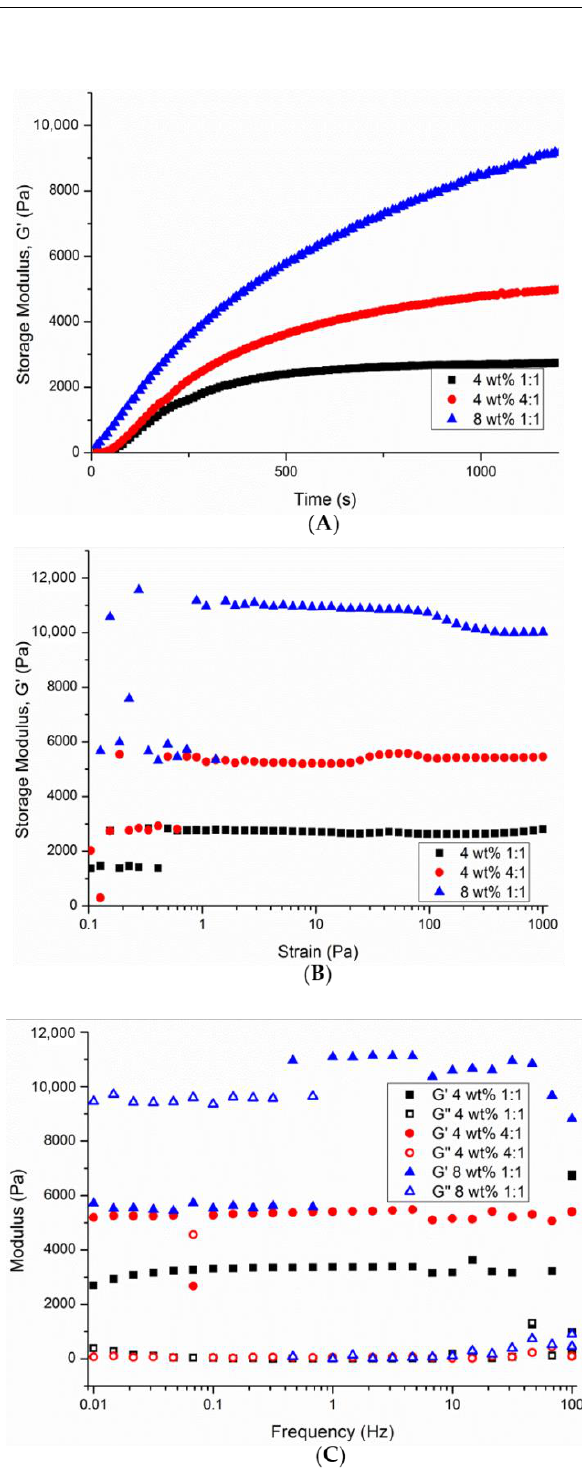
Figure 3. Rheological analyses of P(KA)/4-PEG hydrogels with 4 wt% (1:1 and 4:1 molar ratios) and 8 wt% (1:1 molar ratio) under ( A ) time sweep, ( B ) strain sweep and ( C ) frequency sweep settings.